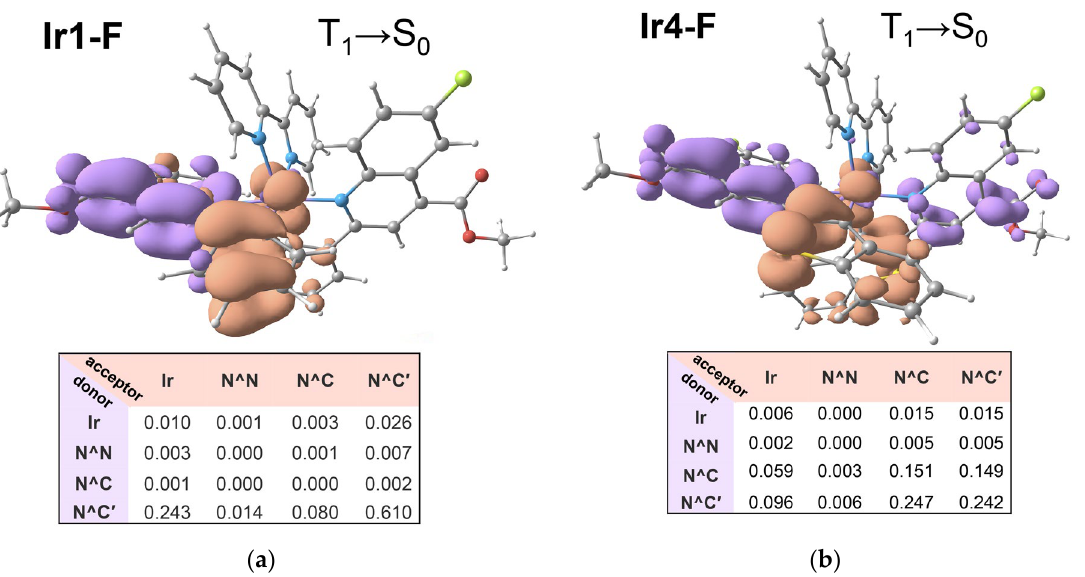
Figure 4. NTO of the emission (T 1 → S 0 ) transition in the complexes Ir1-F ( a ) and Ir4-F ( b ): decrease and increase in electron density are shown in violet and terracotta colors, respectively, and corre- sponding interfragment charge transfer (IFCT) tables showing contribution of charge transfers be- tween certain molecular fragments: iridium ion (Ir), N^C and N^N ligands.